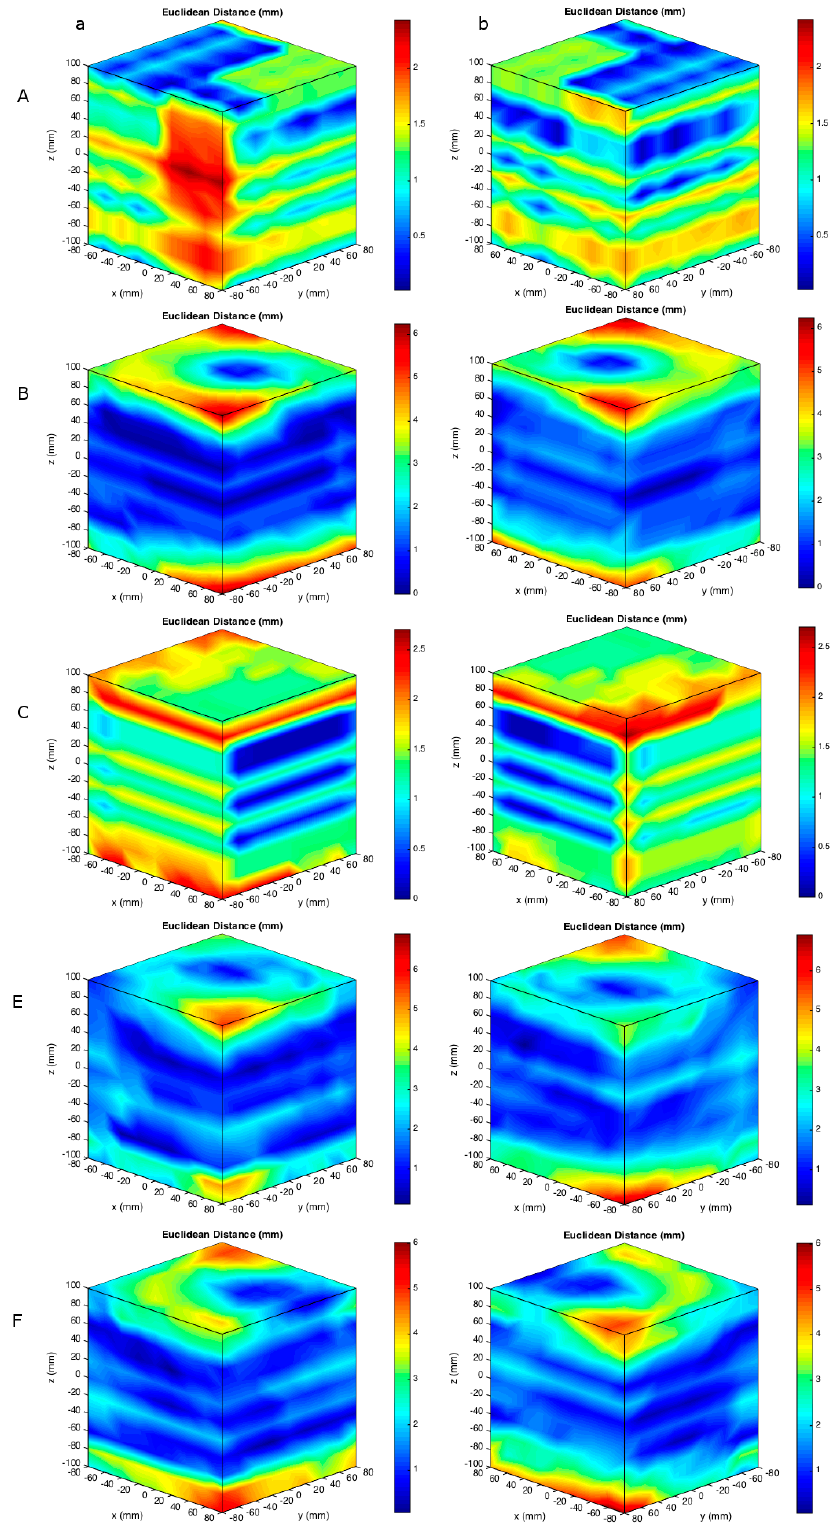
Figure 4. Euclidean distance error volumes for systems A, B, C, E and F ( a ) (azimuth 45°, elevation 20°) and ( b ) (azimuth 225°, elevation 20°). For system D see Figure 3.